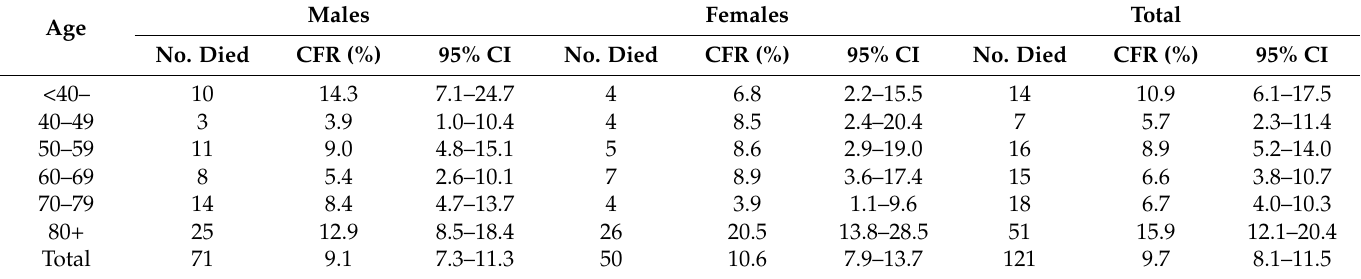
Table 1. In hospital first time stroke case fatality rate (%) and concomitant 95% Confidence Intervals (95% CI) by age groups and gender.